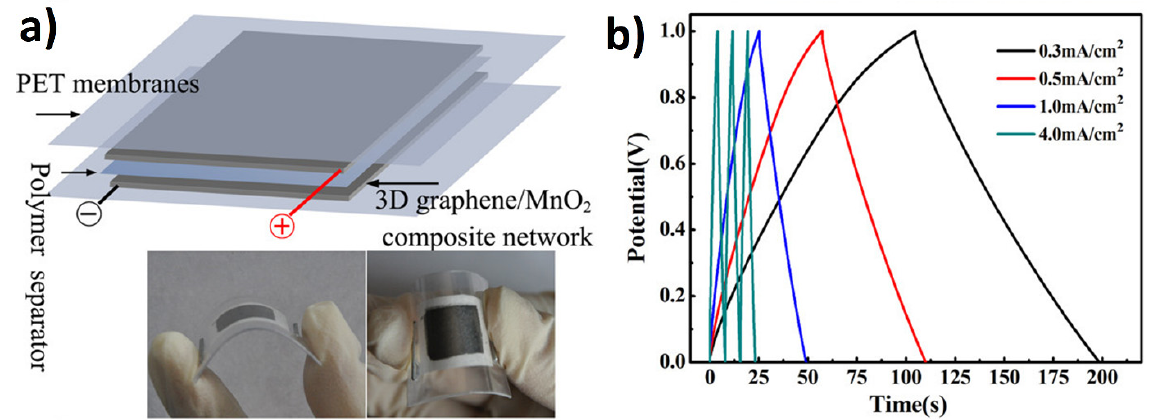
Figure 9. ( a ) Schematic of the flexible supercapacitors consisting of two symmetrical graphene/MnO 2 composite electrodes, a polymer separator, and two PET membranes. The two digital photographs show the flexible supercapacitors when bent; ( b ) Galvanostatic charging/discharging curves of the flexible supercapacitor device at different current densities. Reprinted with permission from ref. [64]. Copyright 2012 American Chemical Society.